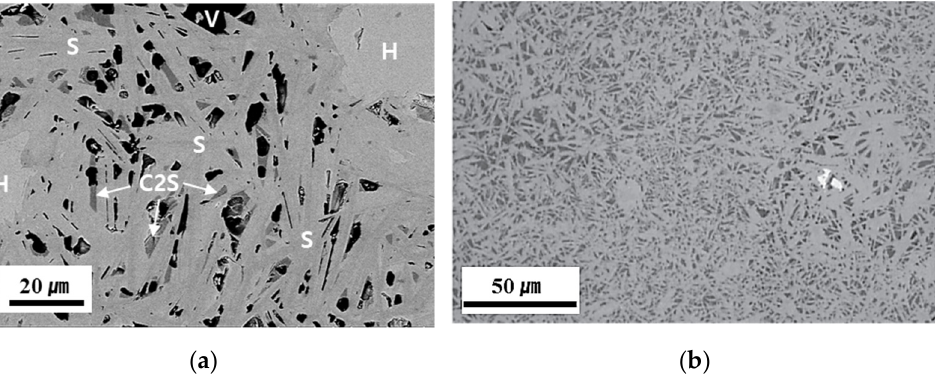
Figure 4. Cross-sectional image and an electron micrograph of the synthetic iron ore sinter [36,50]: ( a ) Sample #8 in Table 5 [50] (V: void; H: hematite; S: silico-ferrite of calcium and aluminum (SFCA); C2S: dicalcium silicate) and ( b ) the SFCA-I matrix texture [36].